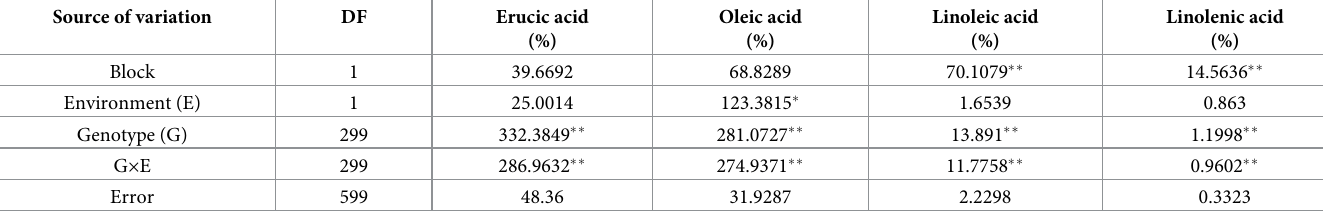
Table 2. Variance analysis of seed fatty acid composition of rapeseed in two environments. Source of variation